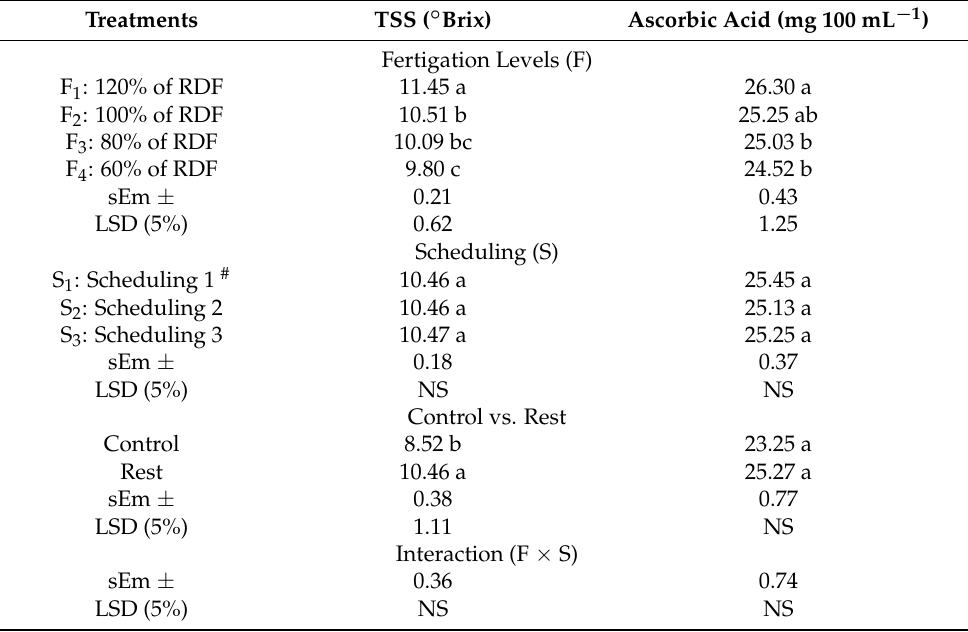
Table 6. Impact of fertigation dose and its application on fruit quality characteristics of tomato (2-years pooled